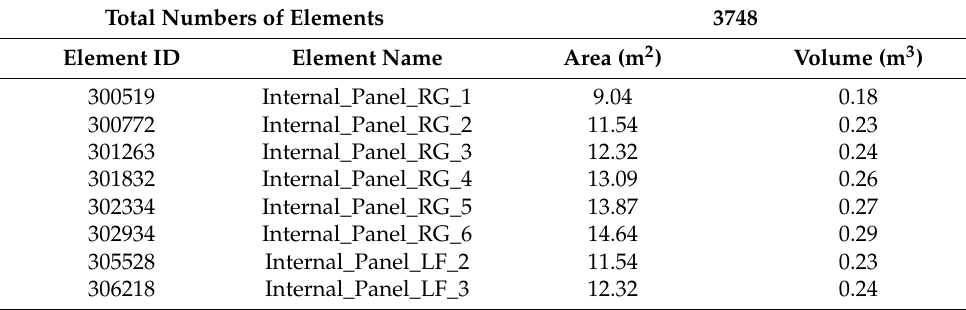
Table 1. Excel sheet written with Dynamo.